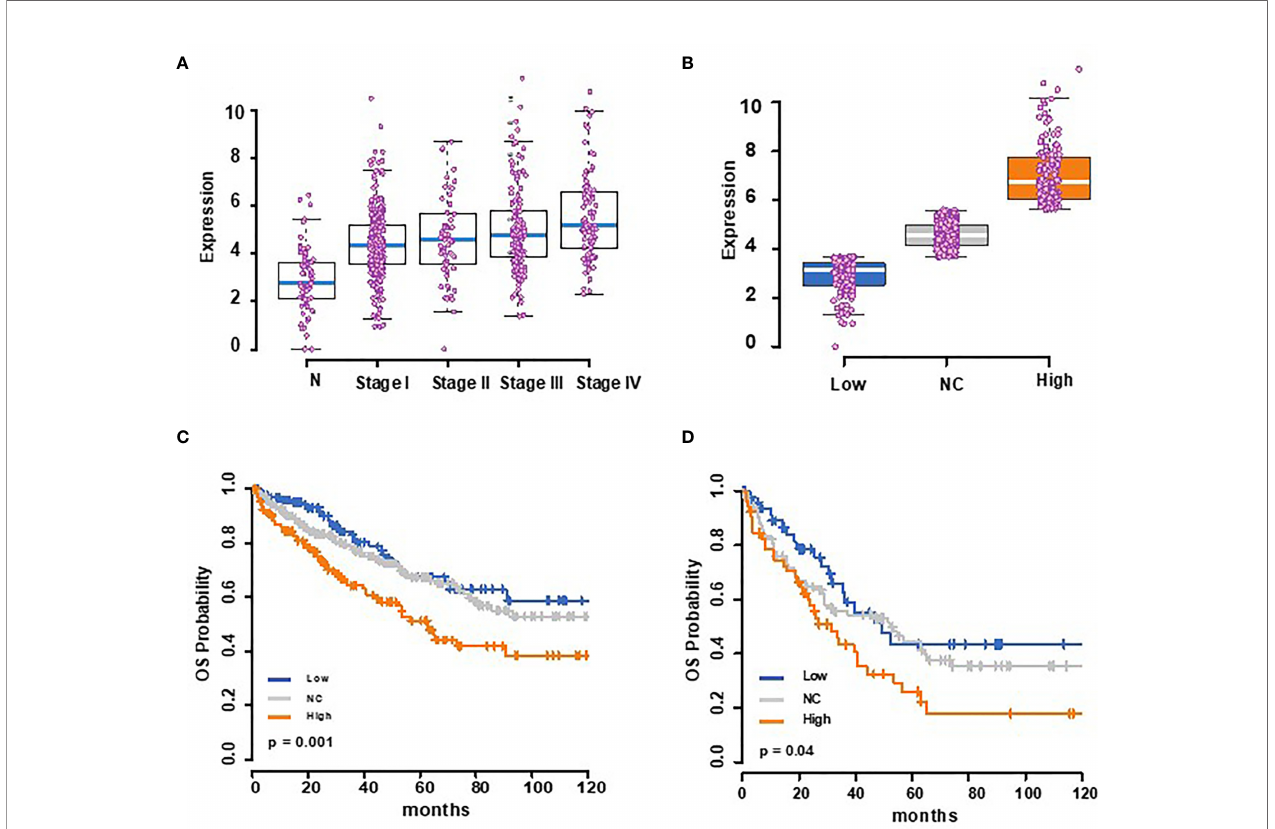
FIGURE 8 | The Cancer Genome Atlas analysis shows that TREM-1 expression is increased in renal cell carcinoma (RCC) patients and correlates with a poor outcome. (A) Box plots showing Trem1 mRNA expression for normal (72) and stages I – IV ( n = 267, 57, 123, and 84, respectively) RCC patients, with the medians represented as blue bars in a box, and each case is shown as a pink dot. (B) Trem1 expression levels in 531 RCC tumor samples from TCGA were strati fi ed into tertiles of Trem1 expression levels (low = 3rd quartile, high = 3rd tertile, and NC = intertertile range. (C) Kaplan – Meier overall survival curves according to this strata and (D) for higher-stage diseases (stage III and